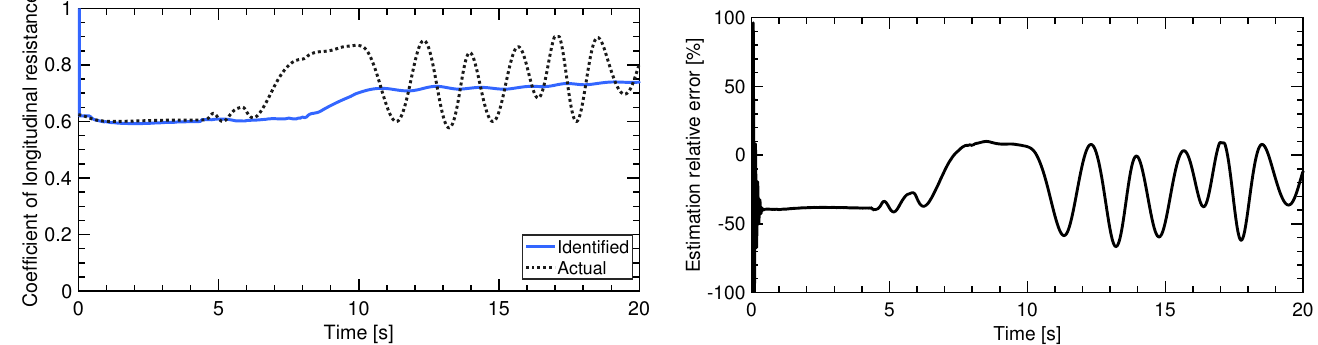
Figure 30. Longitudinal resistance coefficient: identified value ( left ) and relative error ( right ).